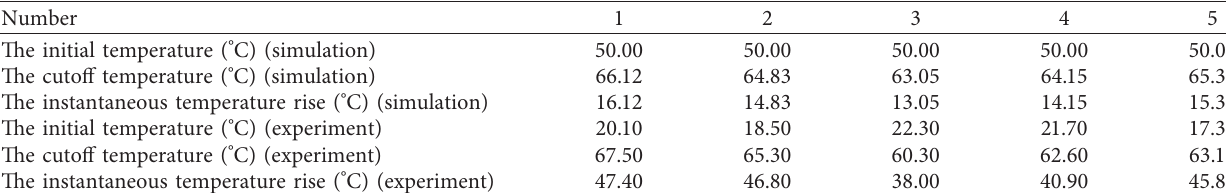
Figure 21: Tooth surface thermal image of the driving gear running for 40minutes at different injection speeds: (a) Model 1; (b) Model 2; (c) Model 3; (d) Model 4; (e) Model 5. Table 6: Comparison of simulation and experimental data.